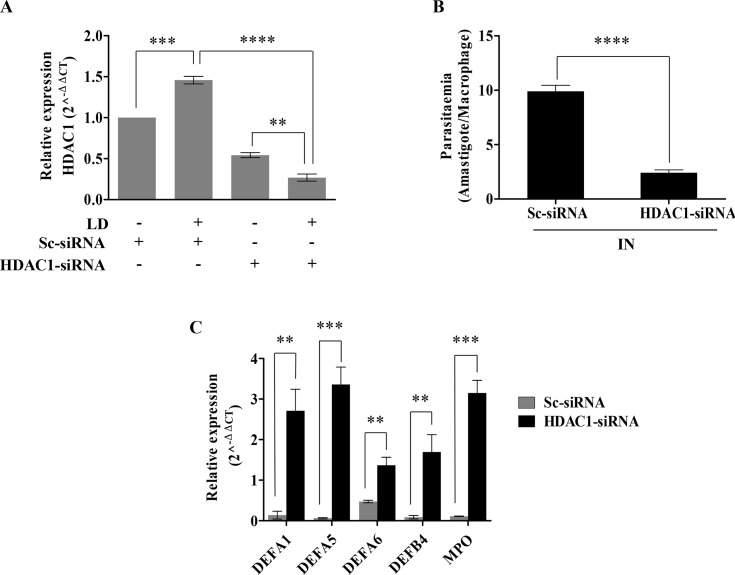
Effect of HDAC1 silencing on the expression of host defense genes and intracellular parasite load in L. donovani infected THP-1 cells.THP-1 cells (105 cells/ml) were transfected with HDAC1-siRNA (600 pmol) using lipofectamine. Scrambled-siRNA transfected THP1 cells were used as a control. After 24 h of transfection, the THP-1 cells were infected with L. Donovani (20:1 MOI). The cells were then harvested at 6 h post-infection, and RNA was extracted, followed by qRT-PCR to determine the impact of HDAC1 silencing on host defense genes and intracellular parasite load. A: Expressions of HDAC1were quantified by qRT-PCR. Fold change values of HDAC1 mRNA is represented relative to uninfected-Sc-siRNA transfected condition. The basal level of HDAC1 in uninfected-Sc-siRNA transfected cells was used for data normalization and was taken as 1.0. B: THP1 cells were transfected with HDAC1-siRNA or Sc-siRNA for 24 h and were then incubated with L. donovani (IN) for 3 h. After 6 h post-infection, cells were stained with Giemsa and the number of infected cells and the number of amastigotes were counted visually. C: Expression of defense genes in infected THP-1 cells transfected with HDAC1-siRNA or Sc-siRNA was determined by qRT-PCR.Results represent mean ± SD (n = 3). Significance was calculated by ANOVA, ** (P≤.01), *** (P≤0.001) and **** (P≤0.00001).